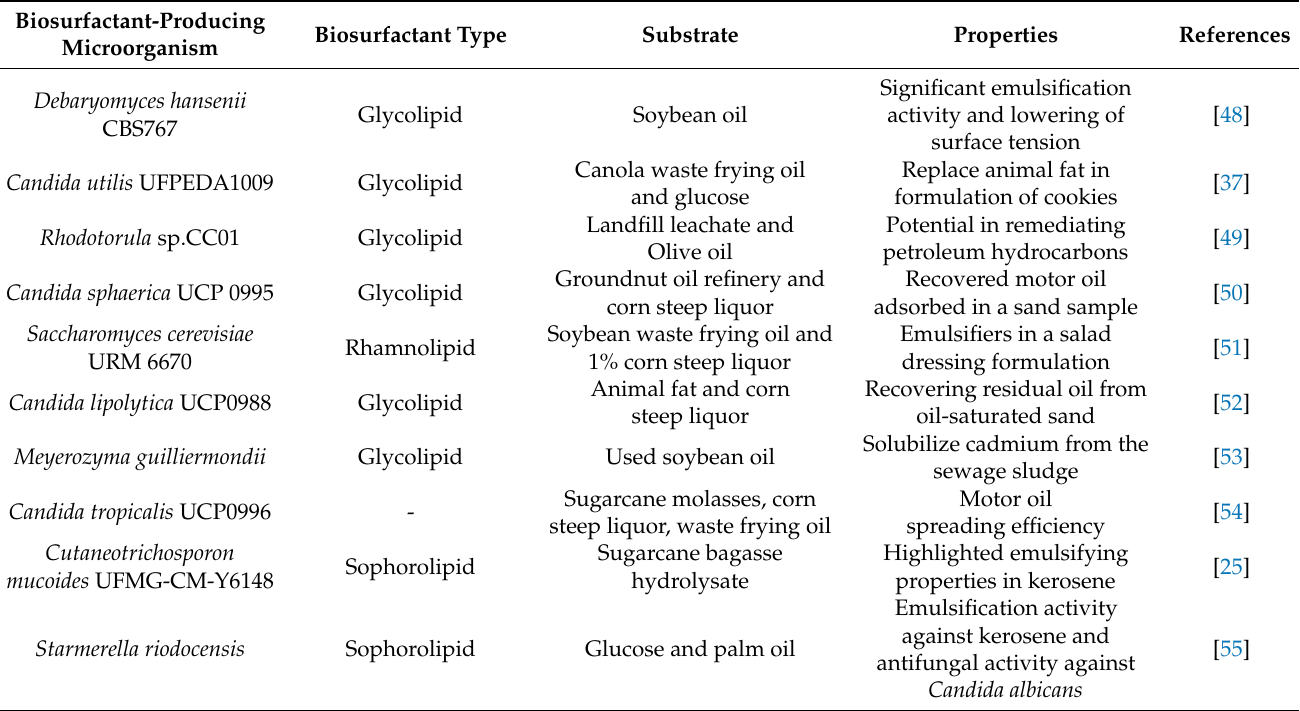
Table 1. Yeast-producing BS using different substrates.